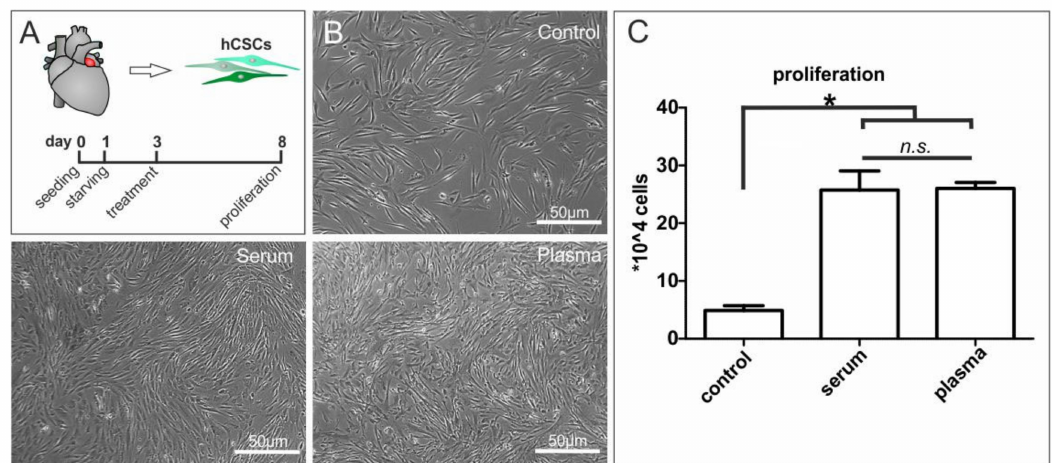
Figure 2. Application of human blood serum and human blood plasma on adult human cardiac stem cells led to increased cell proliferation. ( A ) Primary cultures of human stem cells from the adult heart auricle where exposed to blood serum, blood plasma or starvation medium. ( B ) Microscopy images of treated cells demonstrated a proliferation inducing e ff ect of blood serum and plasma compared to untreated cells. ( C ) Serum and plasma significantly increased the proliferation of hCSCs in a similar manner. Mann-Whitney two-tailed, * p < 0.05 was considered significant, not significant (n.s.) p >